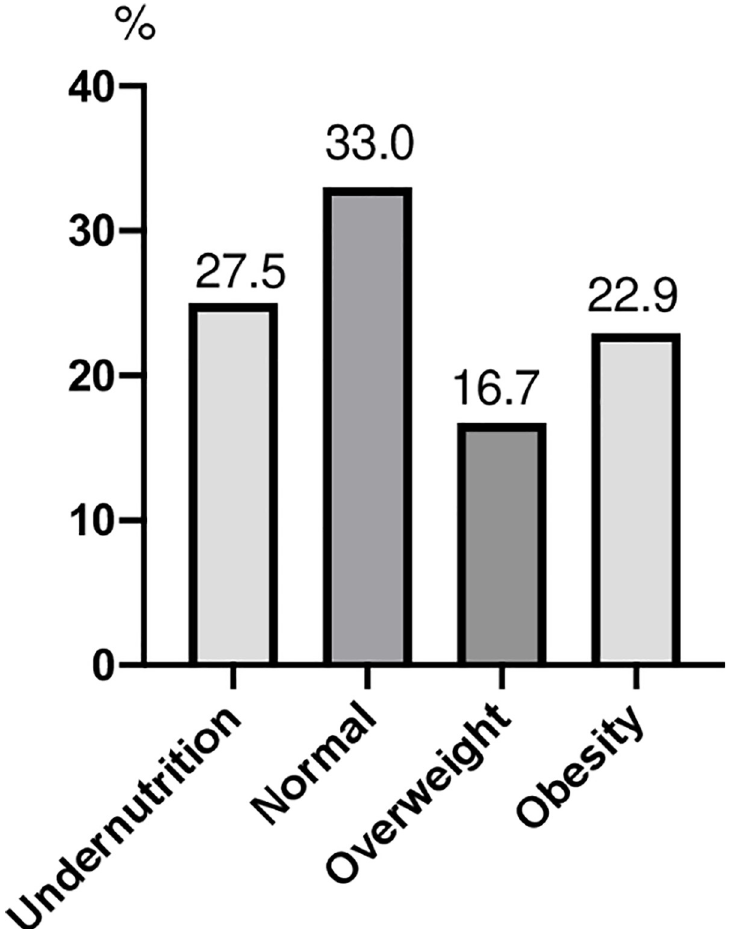
Fig 1. Nutritional status of all residents assessed.